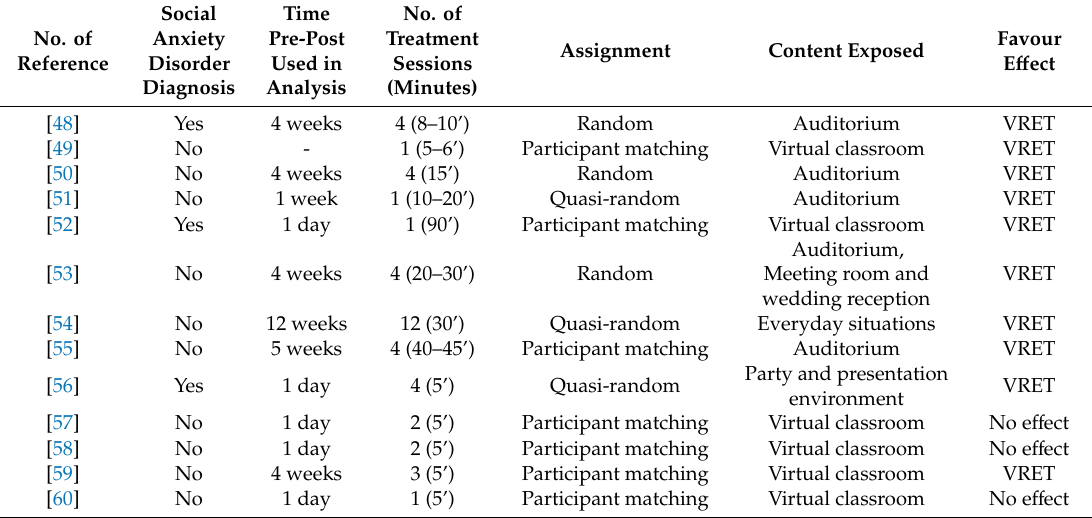
Table 6. Characteristics of the treatment with